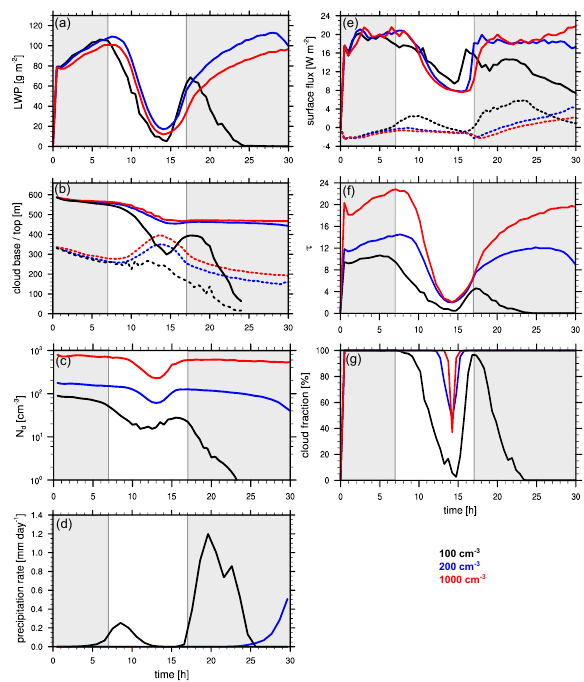
Fig. 5. Time evolution of clean ( N a = 100cm − 3 , black), semi-polluted ( N a = 200cm − 3 , blue), and polluted ( N a = 1000cm − 3 , red) cloud (2.5 × 2.5km 2 horizontal domain): (a) average LWP; (b) average cloud top (solid line) and cloud base (dashed line) height, where the cloudy grid is defined as grid with cloud water mixing ratio > 0.01gkg − 1 ; (c) cloud droplet number concentration N d , averaged over the cloudy grid; (d) surface precipitation rate, hourly averaged; (e) domain average surface latent (solid line) and sensible (dashed line) heat flux; (f) average cloud optical depth; (g) cloud fraction, defined by cloud optical depth > 2. Gray regions are for the nighttime conditions (0–7 h and 17–30 h), while write regions are for the daytime conditions (7–17 h).